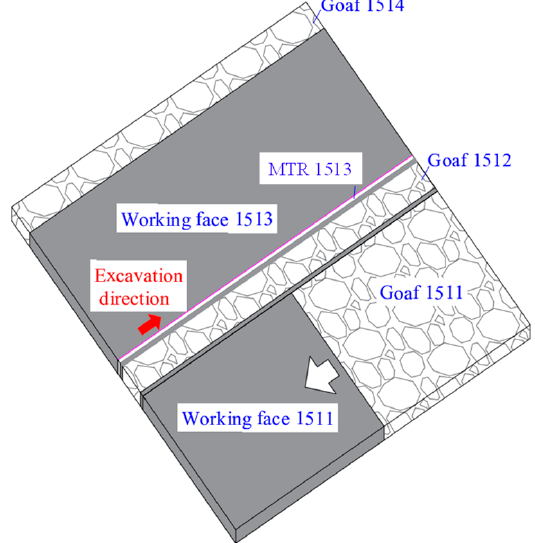
Figure 1. Roadway layout and mining environment.